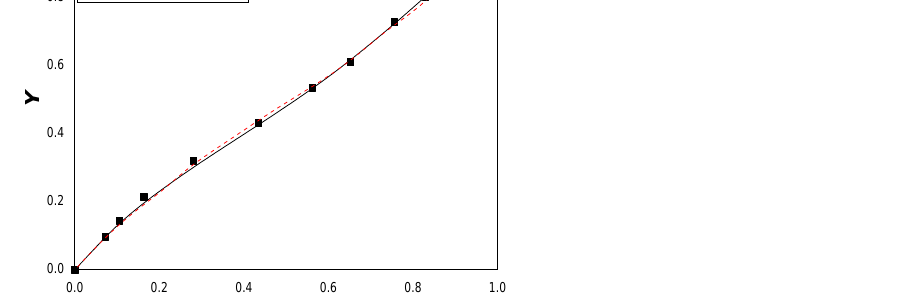
0.0 Figure 5. Experimental and calculated data X’Y diagram for cyclohexane (1) + benzene (2) + DES(1:1) (3) at constant pressure (101.325 kPa) and constant DES molar fraction ( X 3 = 0.1).